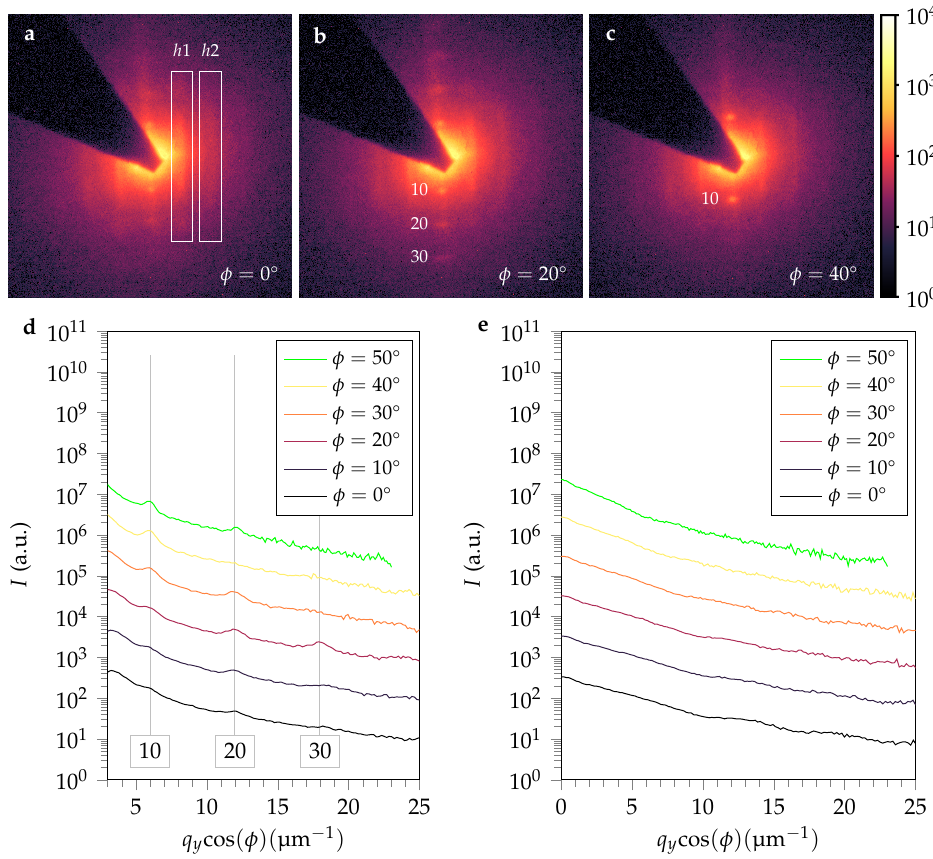
Figure 5. ( a – c ) 2D SAXS patterns of a monolayer prepared from hollow colloidal silica superballs with an average shape parameter of m = 3.63 ± 12% and diameter of D = 1.01µm ± 6.6% imaged at different rotations around the x -axis of φ . The Bragg peaks are labelled on their left. ( d , e ) Vertical cross sections of the diffraction patterns at ( d ) q x = 0µm − 1 and ( e ) q x = 5.76µm − 1 . The vertical lines indicate the q y cos ( φ ) positions of the identified